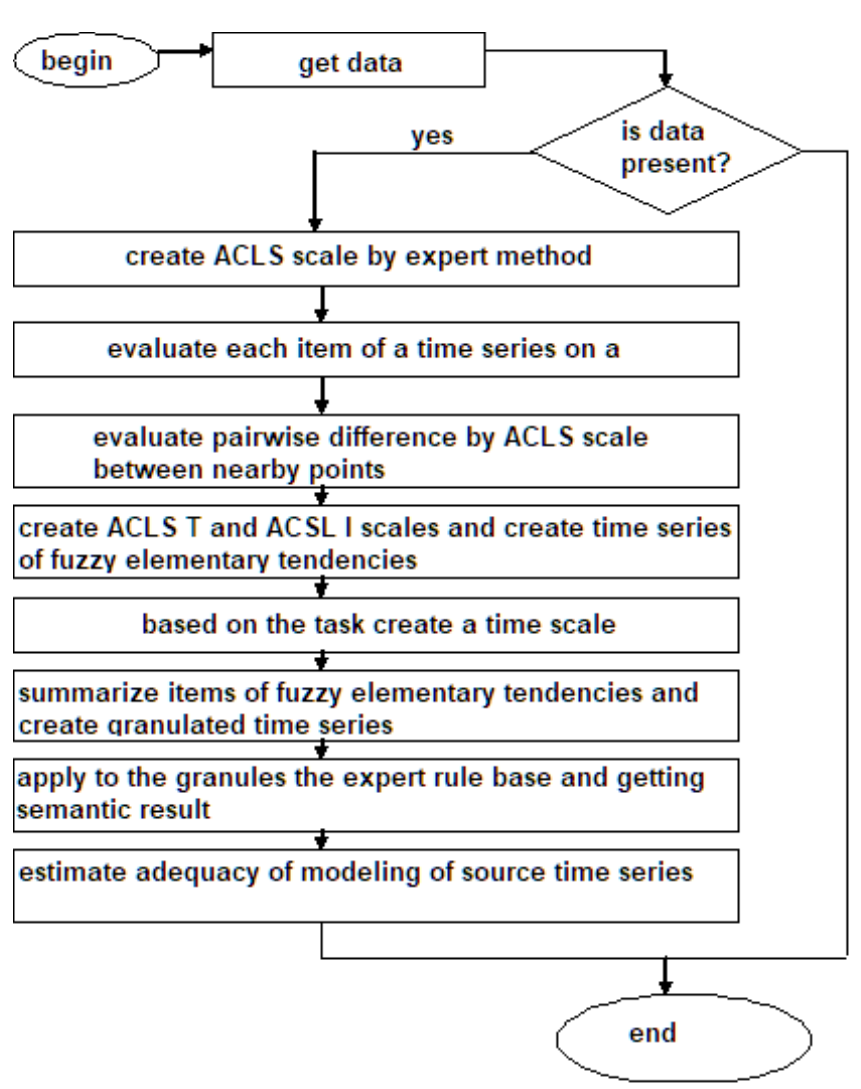
Figure 5. Algorithm of expert evaluation of the helicopter